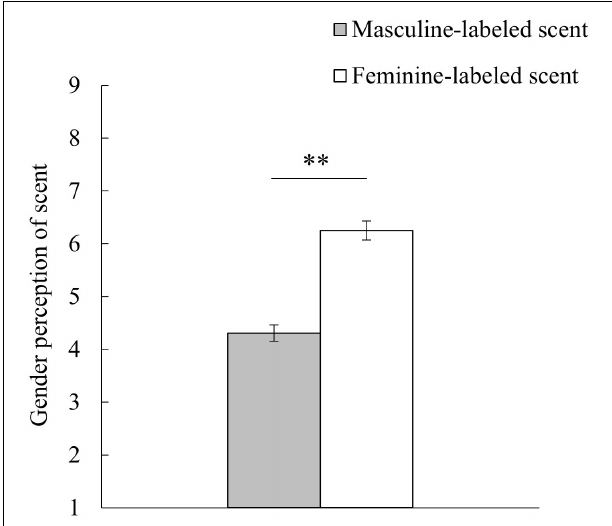
FIGURE 3 | Effects of gender labeling on gender perception of scent. “1: extremely masculine” to “9: extremely feminine”; error bars indicate standard errors. ∗∗ p < 0.01.